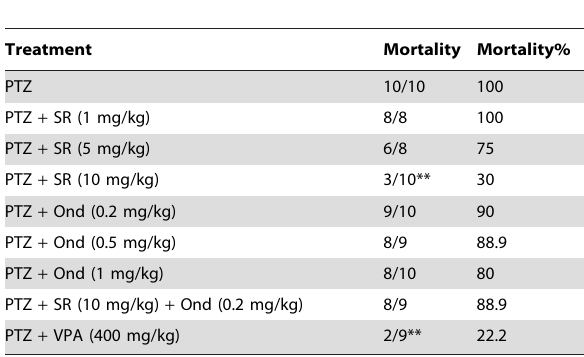
Table 1. Effects of SR 57227 and ondansetron on PTZ- induced seizure score in mice.